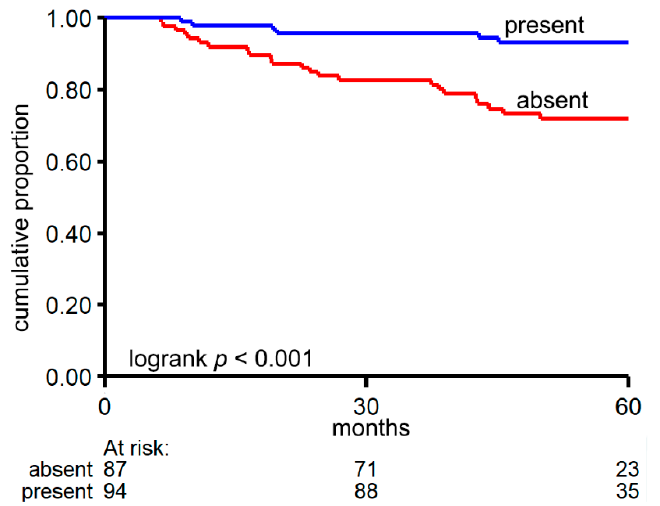
Figure 6. Kaplan–Meier analysis of patients in whom circMGA was detected ( n = 94) versus patients in whom circMGA was not detected ( n = 87).